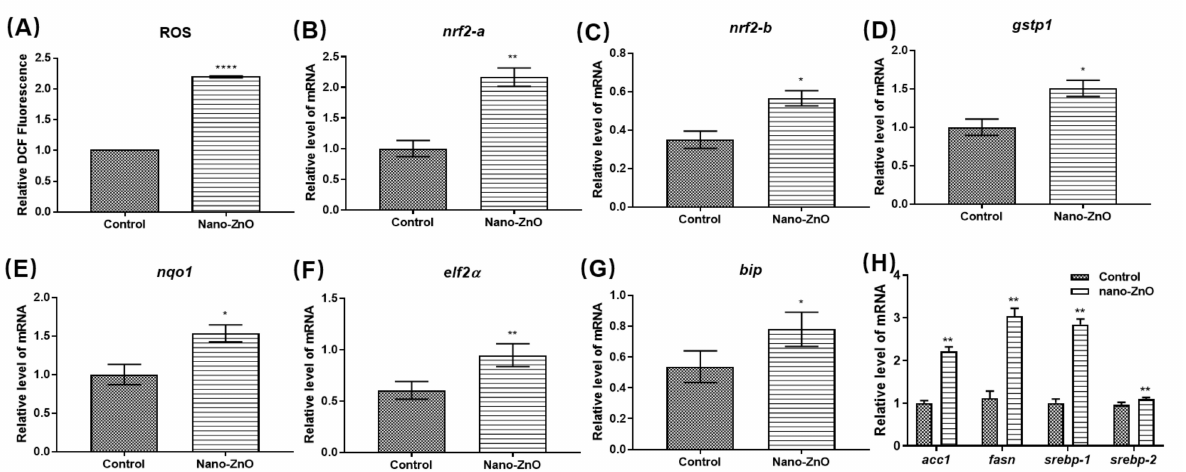
Figure 6. Mechanism of liver injury caused by 125 nmol/mL Nano-ZnO. ( A ) Relative levels of ROS; changes in mRNA levels of antioxidant signaling pathways ( B ) nrf2-a, ( C ) nrf2-b, ( D ) gstp1, and ( E ) nqo1; changes in mRNA levels of ER stress-related genes ( F ) elf2a and ( G ) bip. ( H ) Changes in mRNA levels of the lipid metabolism-related genes acc1, fasn, strebp-1 and strebp-2. ( n = 30, * p < 0.05, ** p < 0.01, **** p <